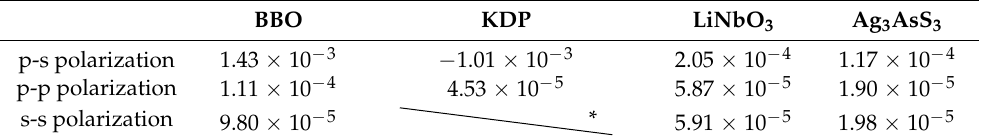
Table 3. The averaged sensitivity of angle measurement in the optical frequency domain.